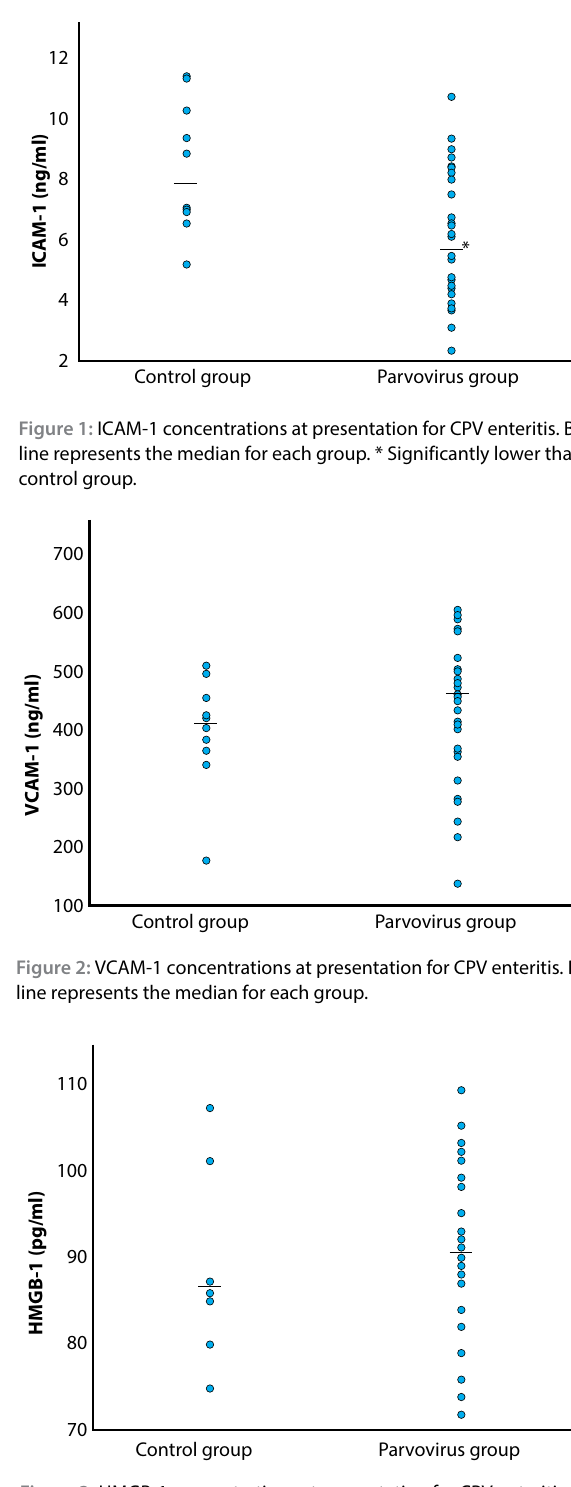
Figure 3: HMGB-1 concentrations at presentation for CPV enteritis. Black line represents the median for each